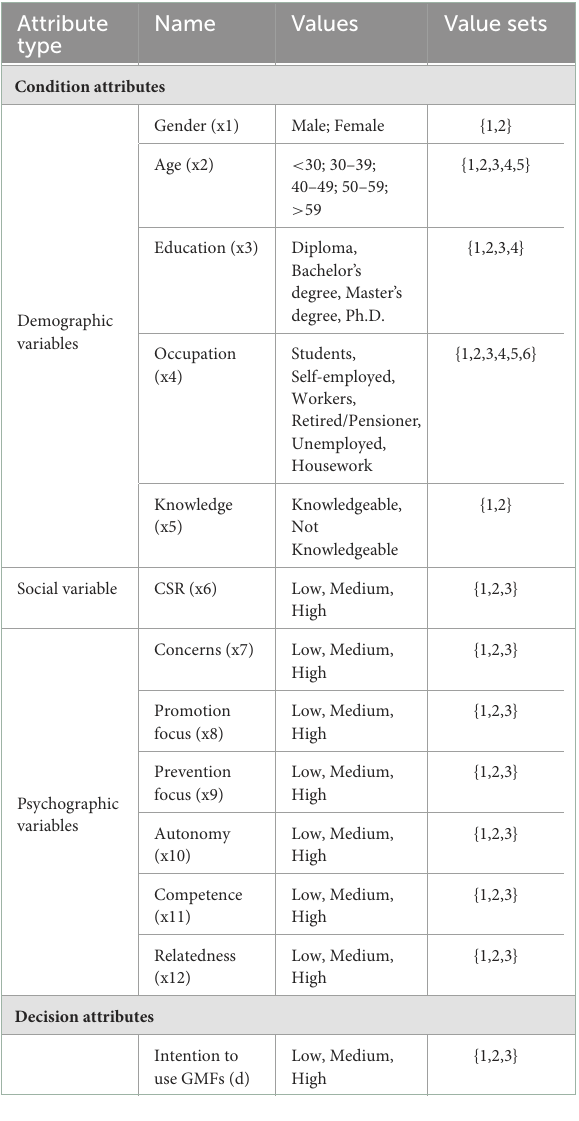
TABLE 2 Attribute specifications and their codes for GMFs consumer behavior